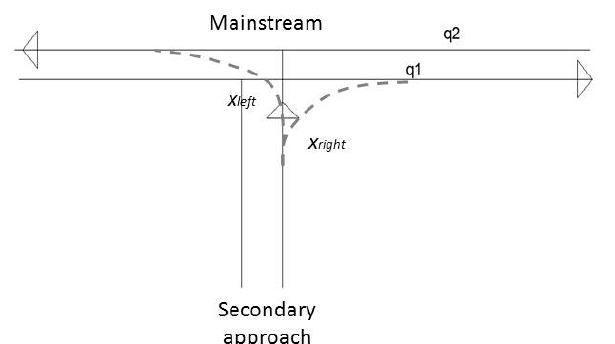
Figure 5. Example of an unsignalized intersection with three